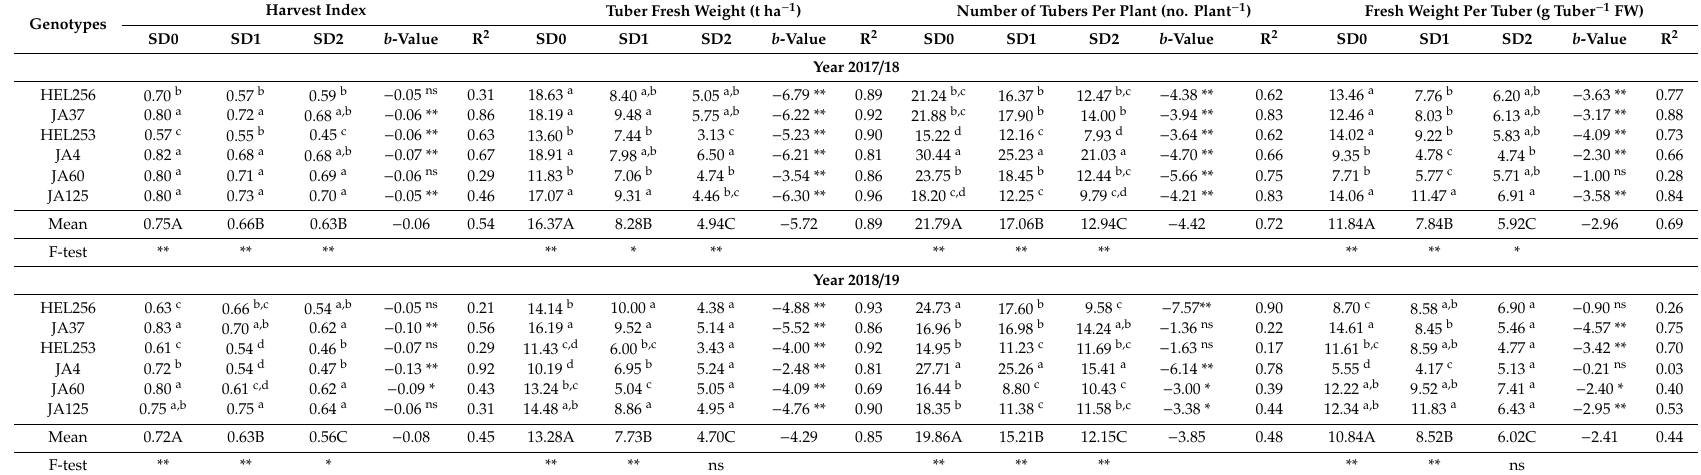
Table 4. Harvest index, tuber fresh weight, number of tubers per plant, fresh weight per tuber, regression coe ffi cient ( b -value) and coe ffi cient of determinations (R 2 ) of six JA genotypes at harvest grown under three drought durations in years 2017 / 18 and 2018 / 19.